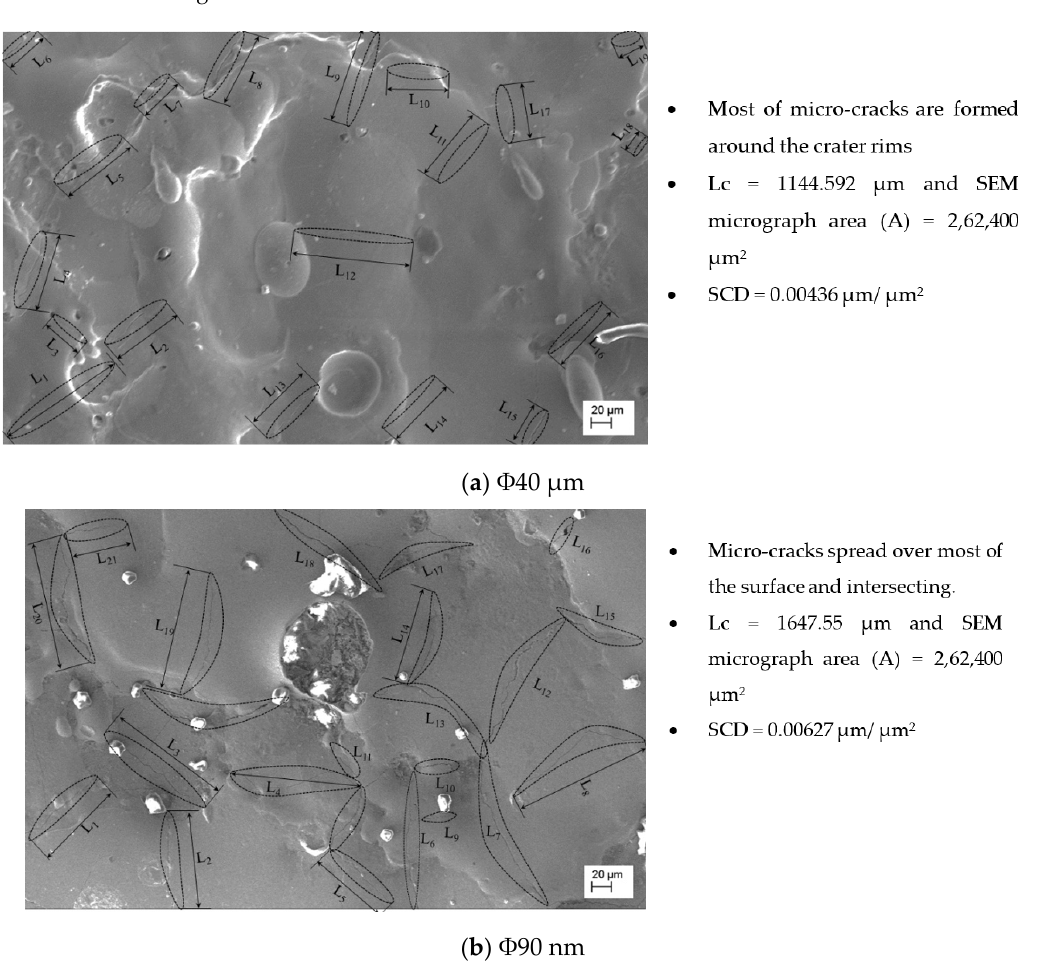
Figure 7. SEM micrographs at 500X for SCD at T d = 300 μs, I p = 6 A, V g = 80 V.